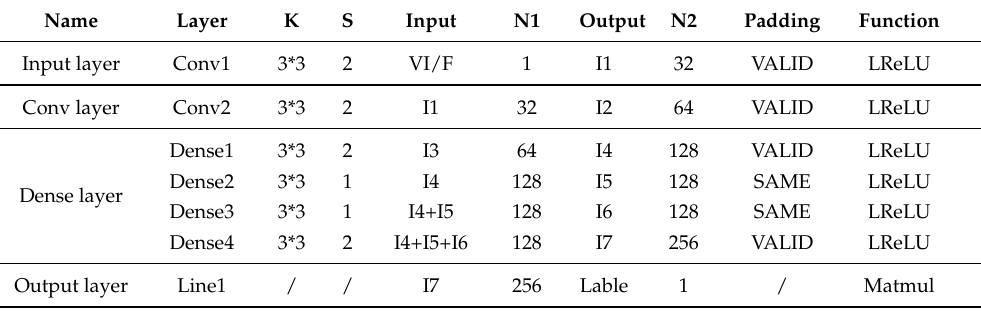
Table 2. Discriminator network architecture